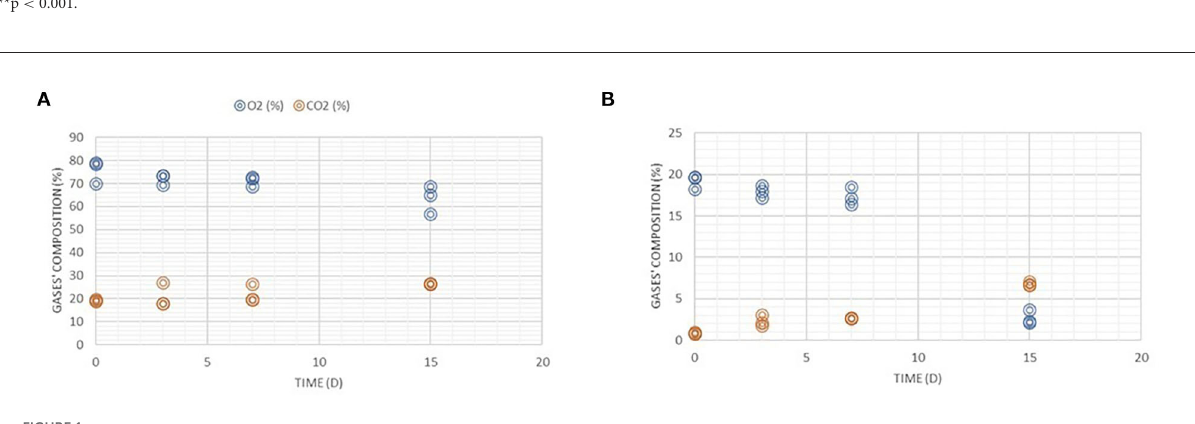
FIGURE1 Trend of the gases’ composition (%) monitored during the refrigerated storage time (0, 3, 7, and 15 days at 4 ◦ C) of all packaged samples in modified atmosphere (A) and in air (B) .